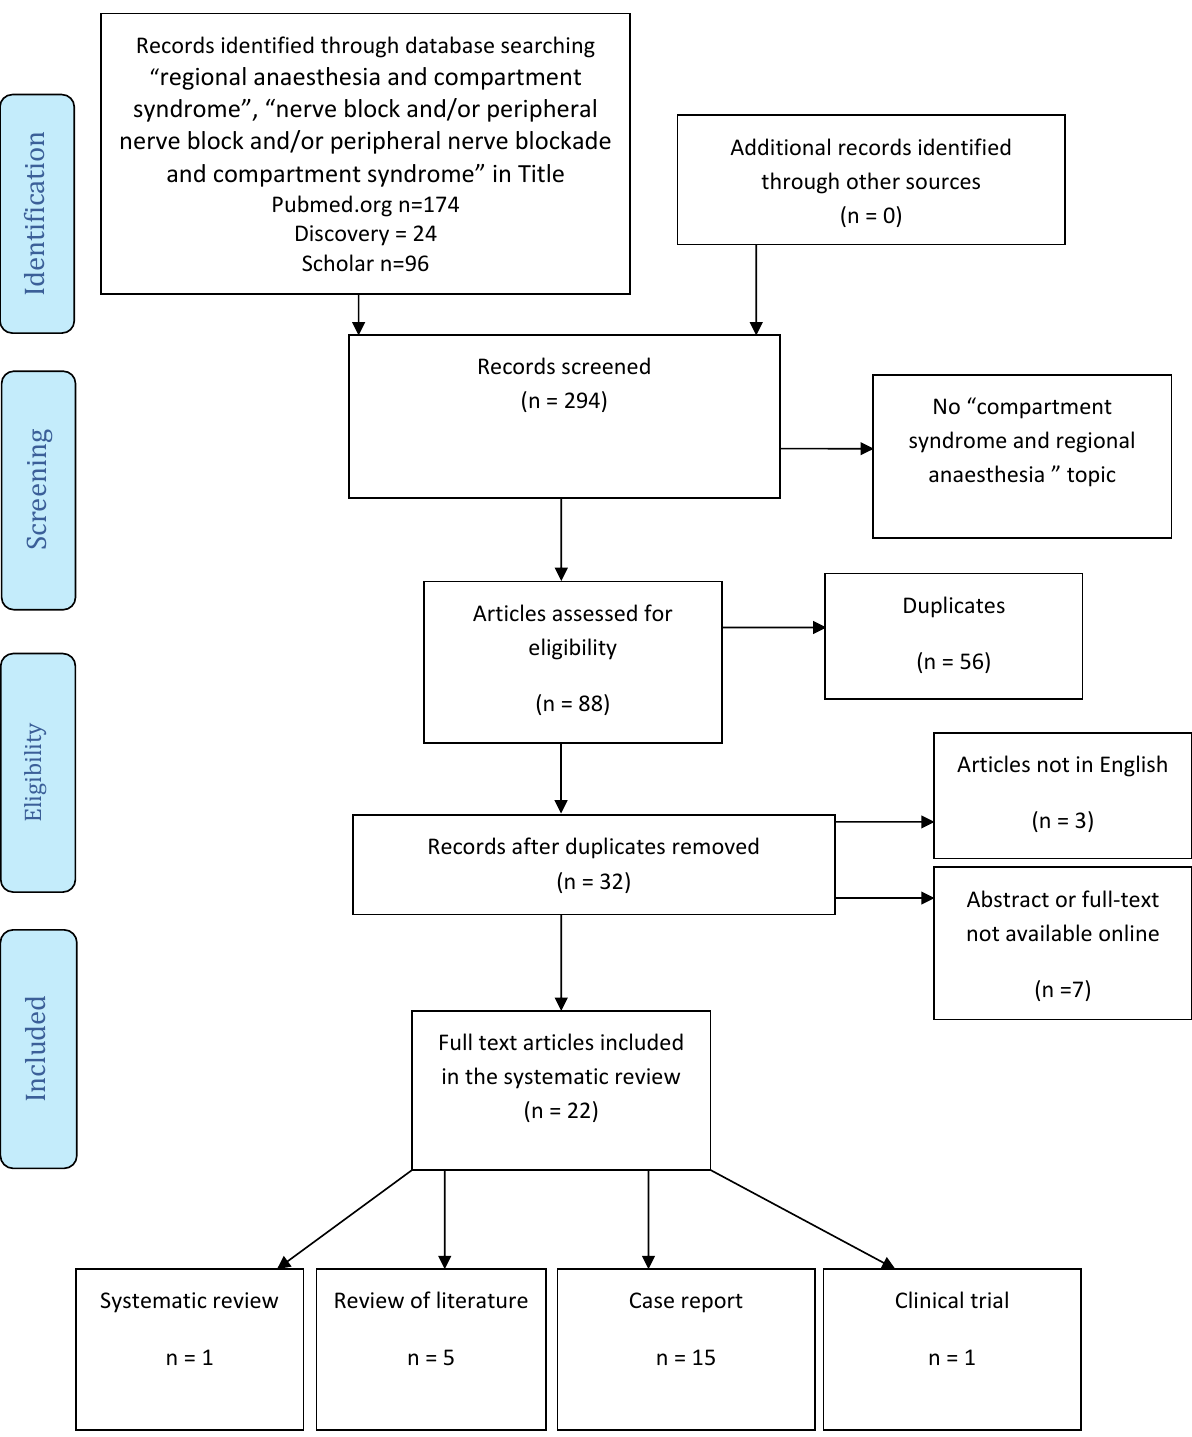
Fig. 1. Data search